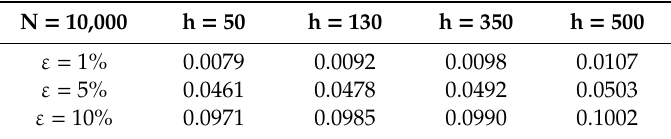
Table 14. Simulated levels of significance for T 2 ( ε 0.01, 0.05,